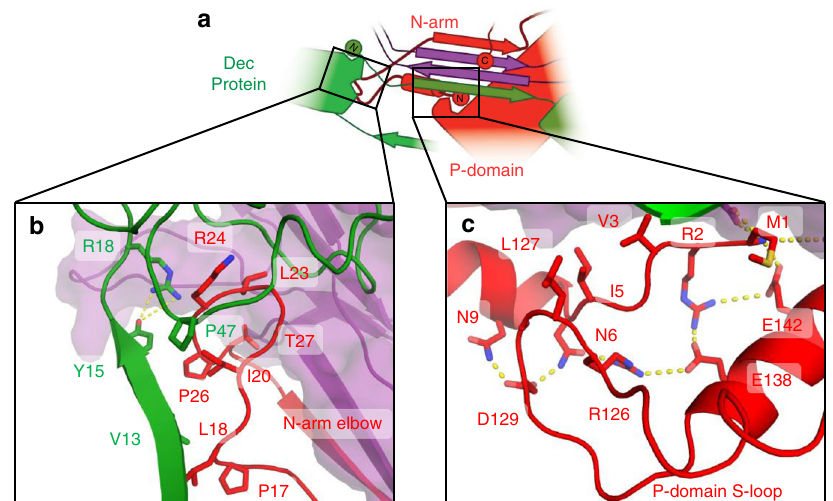
Fig. 6 Lasso interactions stabilizing the N-arm. a Diagram depicting the N-arm lasso interactions with the P-domain (red) and adjacent Dec P74-26 protein (green). b The N-arm elbow (red) extends to the β -tulip domain of a Dec P74-26 protein (green) at an adjacent threefold axis. c The N-arm hand binds to the P-domain S-loop, creating a closed loop lasso